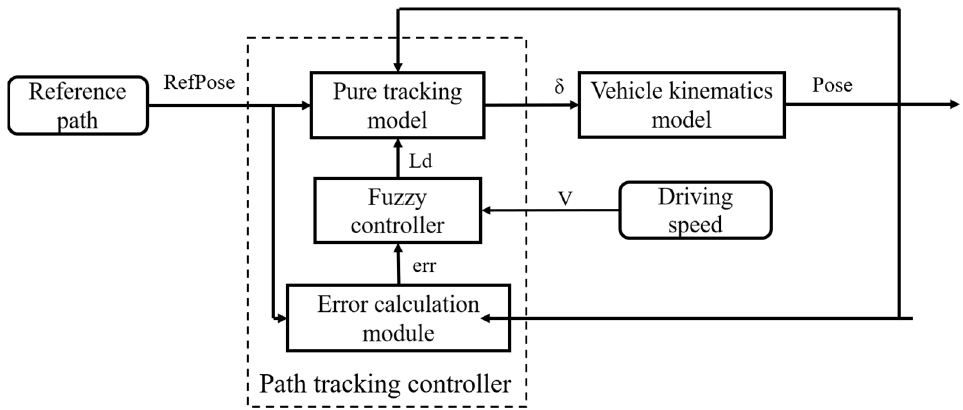
Figure 10. Path tracking simulation flow chart.